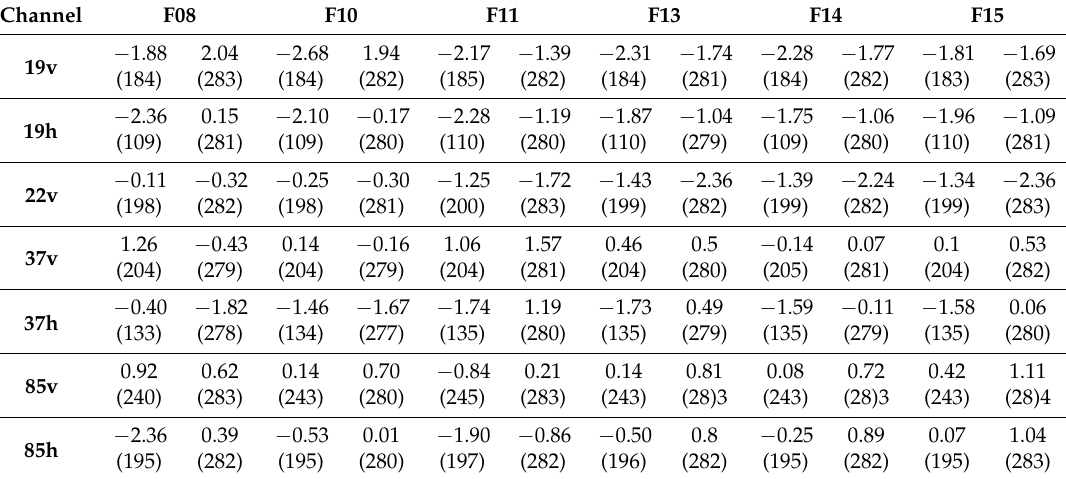
Table 3. Intercalibration offsets in Kelvin for the six SSM/I sensors for both cold and warm scenes. Corresponding scene temperature values are indicated in